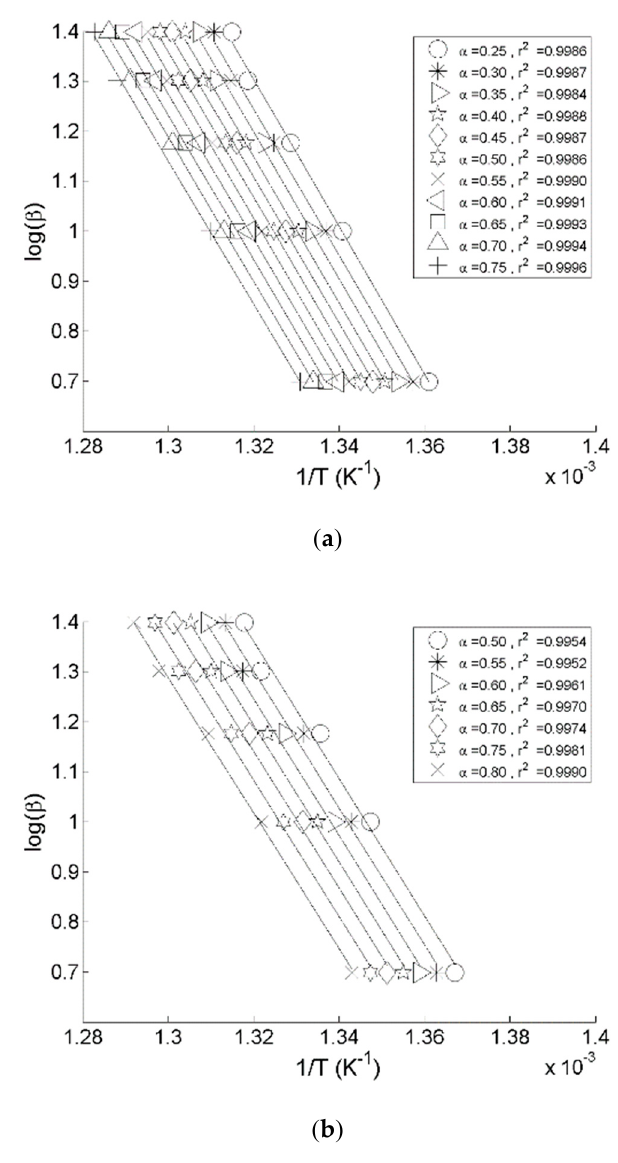
/ T for: ( a ) Façade type 1 material; ( b ) Façade type 2 Figure 2. Plots log β versus 1/T for: ( a ) Façade type 1 material; ( b ) Façade type 2 material. Figure 2. Plots log β versus 1